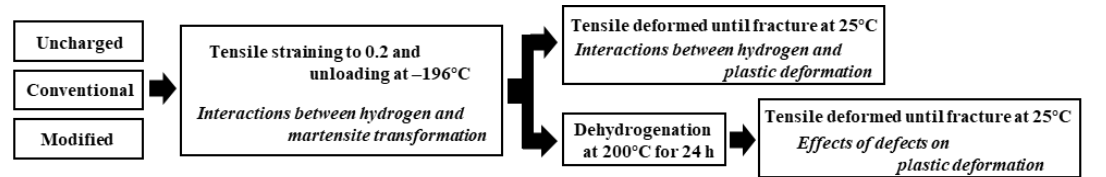
Figure 3. Procedures for investigation effects of interactions between strain-induced martensite transformation and hydrogen on subsequent deformation.